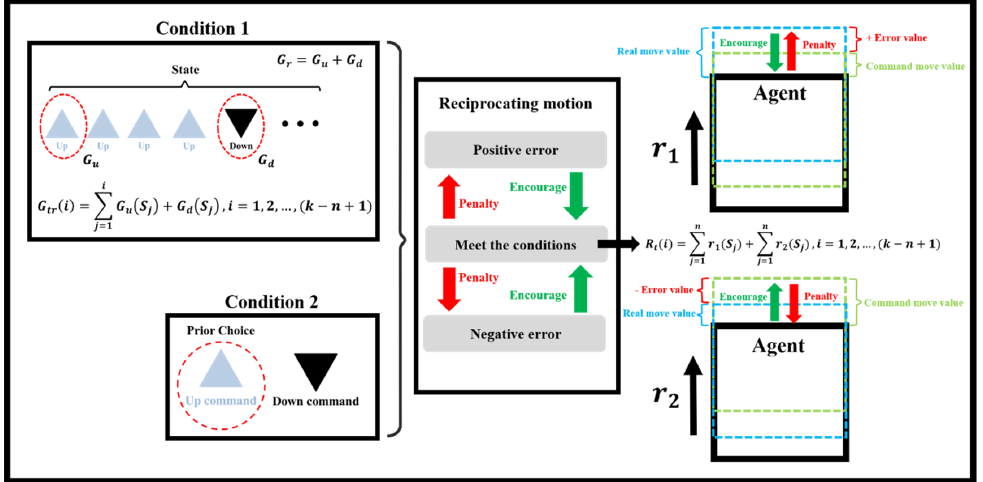
Figure 8. Reward and penalty rules for platform positioning motions.